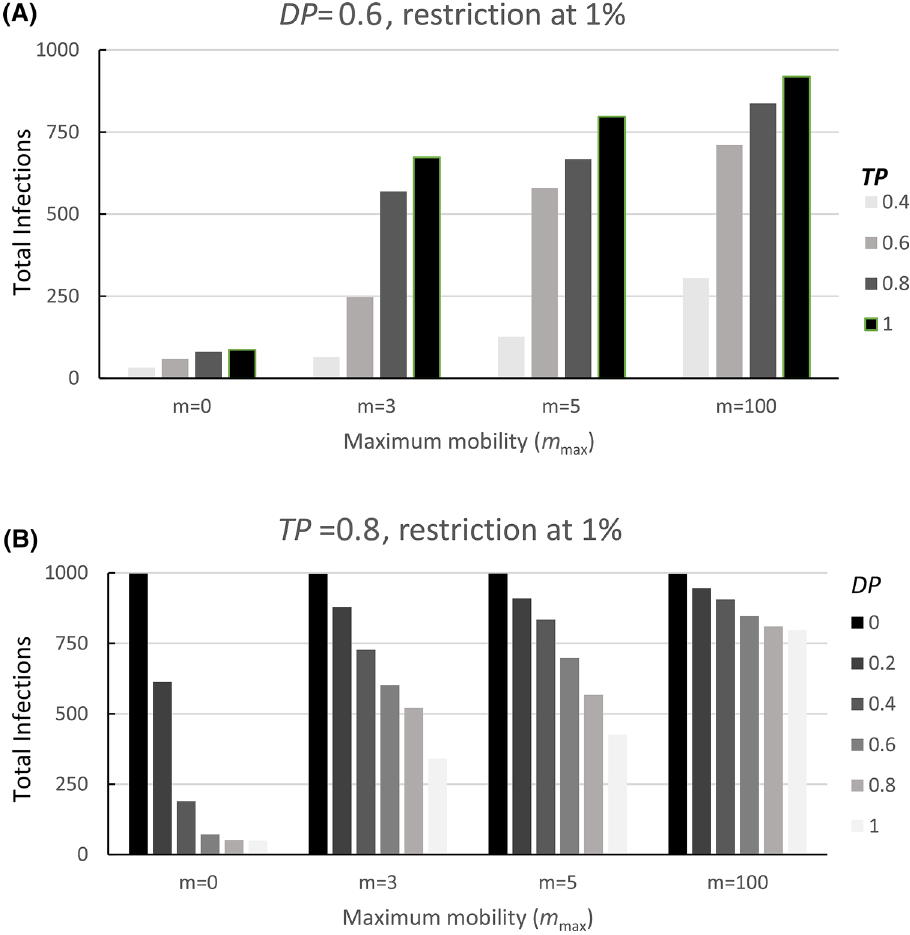
Figure 3. Effects of mobility restriction vs. Detection Probability ( D.P. ) and Transmission Probability ( T.P. ) on infection probability. The other parameters are as follows: N = 1000, M = 2000 and during the non-confinement period, the mobility ( m max ) is set to 100. The mobility was constrained when the number of detected infections reaches 1% (ten people) by setting max ( m )) to the indicated value ( m ). People that are not detected during the 15 days of infection (5 days of asymptotic and 10 days of symptomatic infections) won’t be infectious nor be infected and are practically set apart from the system ( A ) D.P. was varied from 0.0 to 1.0 with T.P. set to 0.8. ( B ) TP was varied from 0.4 to 1.0 using a DP = 0.6. Color codes for D.P. and T.P. are given within the